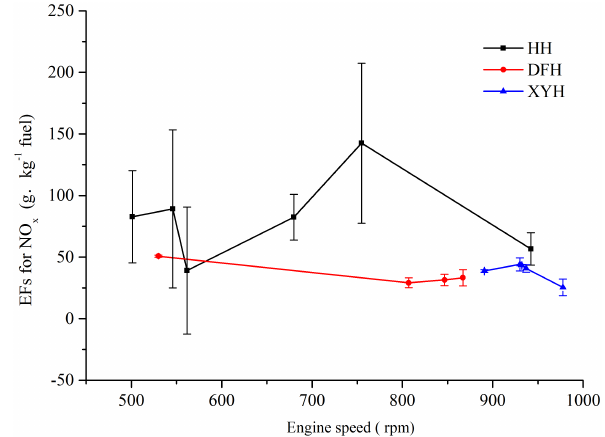
Figure 4. Emission factors for NO x at different engine